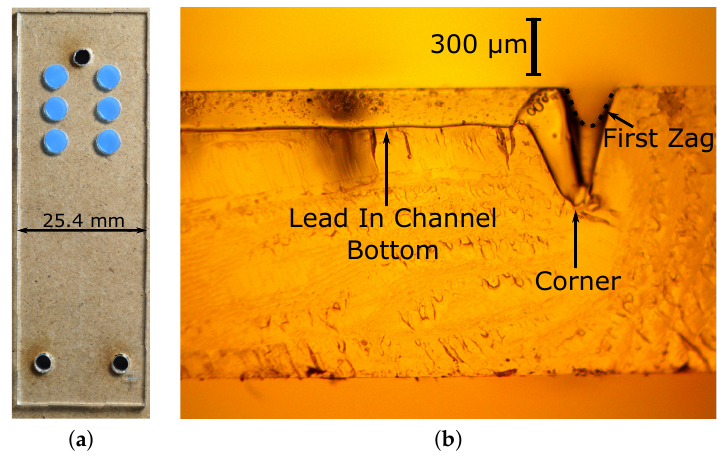
Figure 2. ( a ) As a demonstration of the technique of laser-placement, small circles were patterned by laser in a sample of as-received PMMA that is coated in a layer of blue protective plastic. The blue plastic layer was then peeled off leaving the isolated blue circular membranes in position. A single peeling can prepare a large sheet of an arbitrarily many circles (the release layers actually used were transparent HDPE held in place by van der Waals forces). ( b ) A cross-section of the microchannel leading up to the zig-zag section (the horizontal section is the lead in; the start of the zig-zag goes into the page on the left, outlined by a dashed black line). Additional laser processing of the corner itself has deepened it substantially; the depth is about 200 µ m in the lead-in channel, increasing to (very briefly) 640 µ m, and (going into the page) to 550 µ m before decreasing to 200 µ m in the ‘zag’ channel (without this additional laser processing, the channel corners tended to contain narrowed sections).